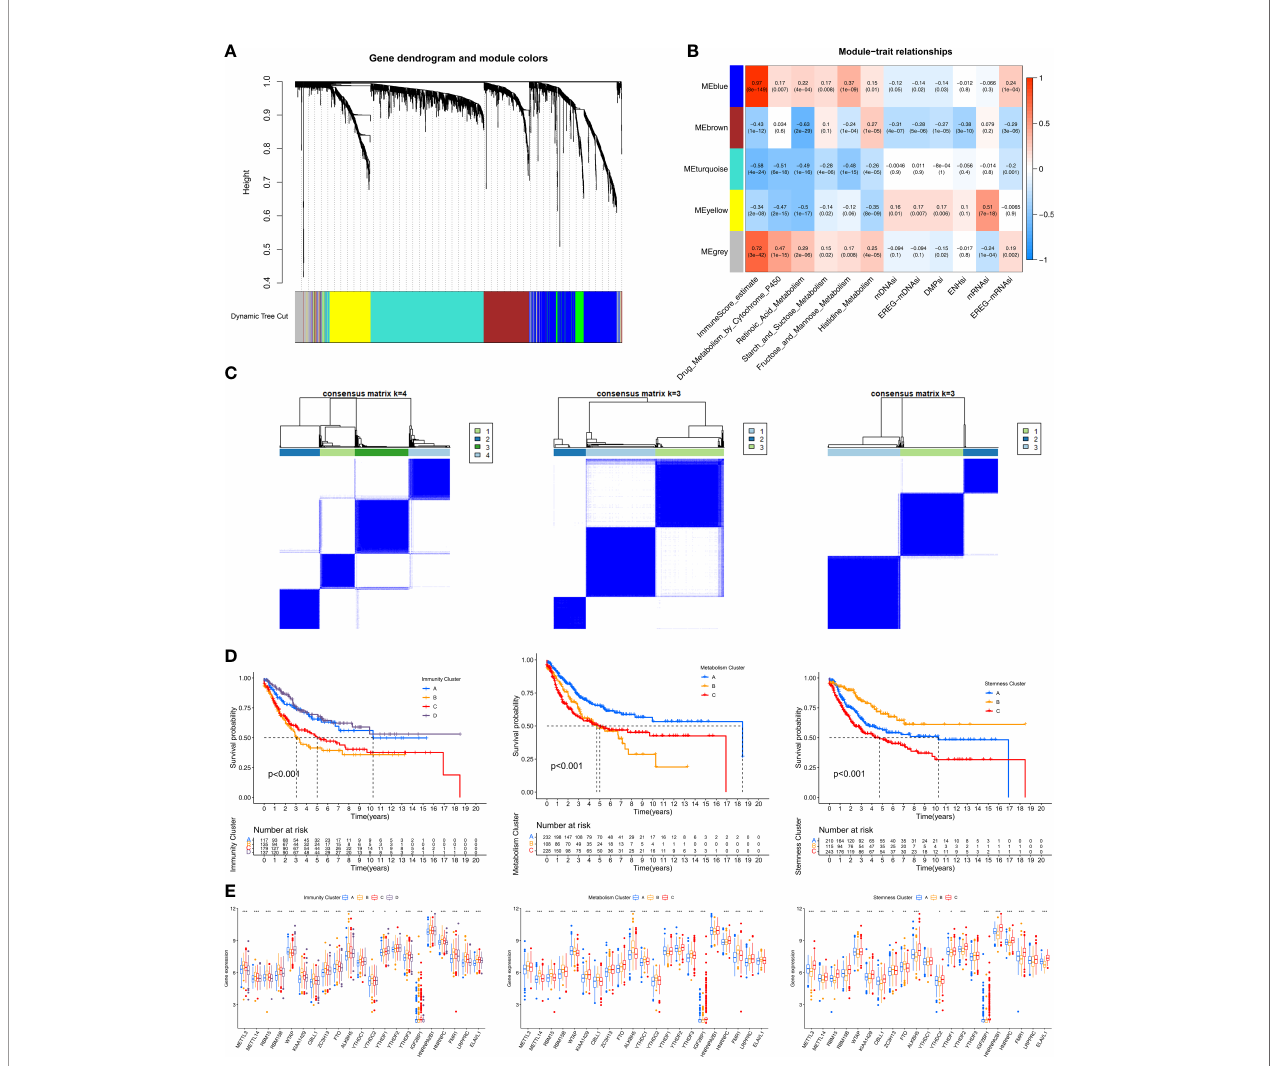
FIGURE 3 | Identi fi cation of hub genes and immunity/metabolism/stemness subtypes by WGCNA. (A) Hierarchical clustering dendrograms of identi fi ed co-expressed genes in modules. The branches of the cluster dendrogram correspond to the different gene modules. Each leaf on the cluster dendrogram corresponds to a gene. Each colored row represents a color-coded module which contains a group of highly connected genes. (B) Correlations between the gene modules and clinical traits. The correlation coef fi cient in each cell represented the correlation between the gene module and the clinical traits. The corresponding P-value and Correlation value are annotated. (C) Heatmap corresponding to the consensus matrix for k=4 (left), 3 (middle), 3 (right) obtained by consensus clustering. (D) Kaplan – Meier curves using the Log-rank test for immunity (left), metabolism (middle) and stemness (right) clusters respectively. (E) The expression of 21 m6A regulators between four immunity (left), metabolism (middle) and stemness (right) clusters. The statistical difference of clusters was compared through the Kruskal – Wallis test. *P < 0.05; **P < 0.01; ***P <